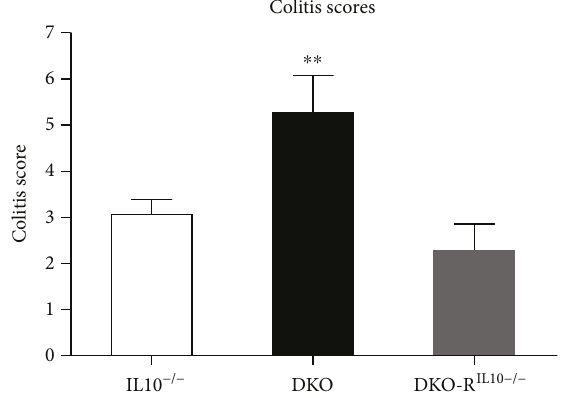
Figure 2: Mast cell-mediated protection against colitis is not IL10- dependent. Reconstitution of DKO mice with IL10 − / − bone marrow- derived mast cells (DKO-R IL10 − / − ) prevents colitis, similar to reconstitution with wild-type mast cells. IL10 − / − : n = 11 ; DKO: n = 11 ; DKO-R IL10 − / − : n = 8 . ∗∗ p < 0 01